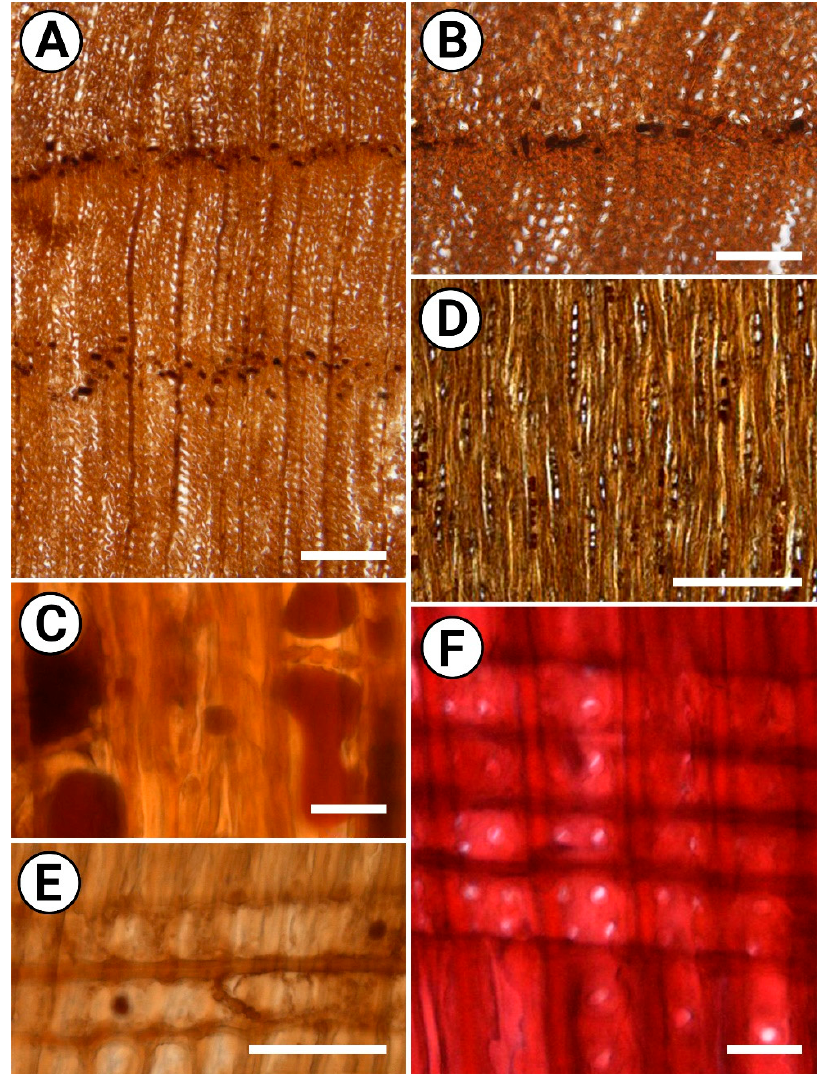
Figure 2. Wood structure of Juniperus sp., light microscopy. ( A ) Transverse section (TS), distinct growth-ring boundary, gradual transition from earlywood to latewood, tangentially zonate axial parenchyma. ( B ) TS, distinct boundary of growth ring, marginal axial parenchyma. ( C ) Tangential longitudinal section (TLS), portions of axial parenchyma strands, nodular transverse wall, dark deposits in axial parenchyma cells. ( D ) TLS, exclusively uniseriate low rays (up to 8 cells in height). ( E ) Radial longitudinal section (RLS), ray cells with thickened pitted horizontal walls and nodular end walls. ( F ) RLS, bordered pits on radial tracheid walls, cross-fields with 2–4 cupressoid pits. Scale bars: 200 μ m for ( A , D ), 100 μ m for ( B ), 50 μ m for ( C , E ), 20 μ m for ( F ).